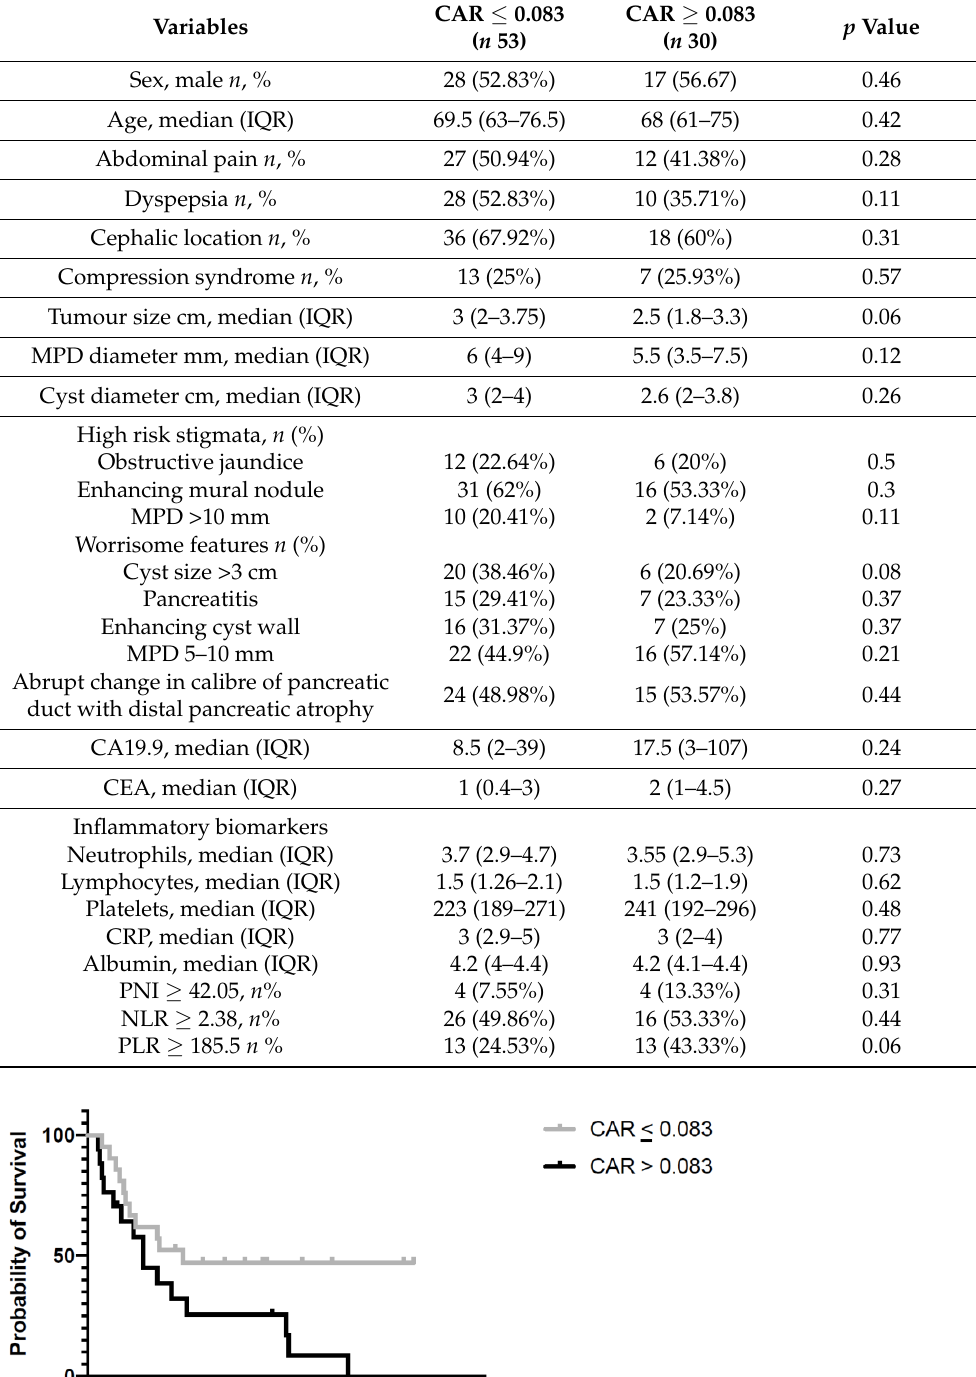
Table 3. Distribution of clinicopathological features and biomarkers between patients with high and low CAR. CAR: C-reactive protein to albumin ratio; IQR: interquartile range; MPD: main pancreatic duct; CRP: C reactive protein; PNI: prognostic nutritional index; NLR: neutrophil-to-lymphocyte ratio; PLR: platelet-to-lymphocyte ratio.